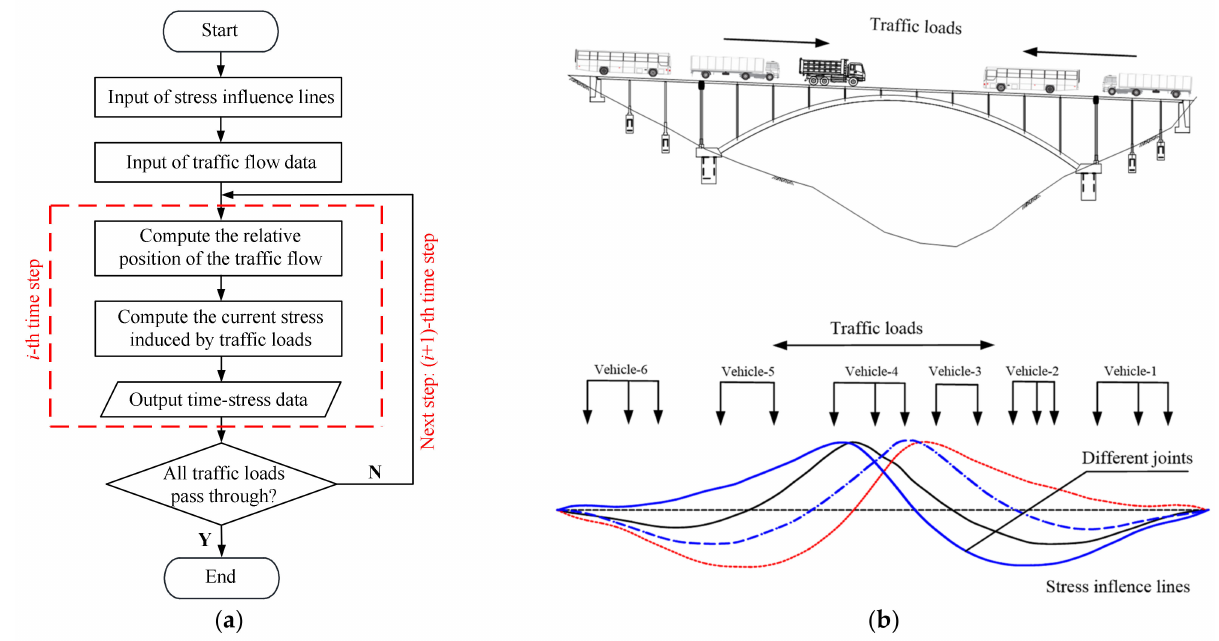
Figure 12. Stress-history analysis of the arch-column joints: ( a ) flowchart of the stress-history analysis; ( b ) movement of the traffic flow on the bridge.